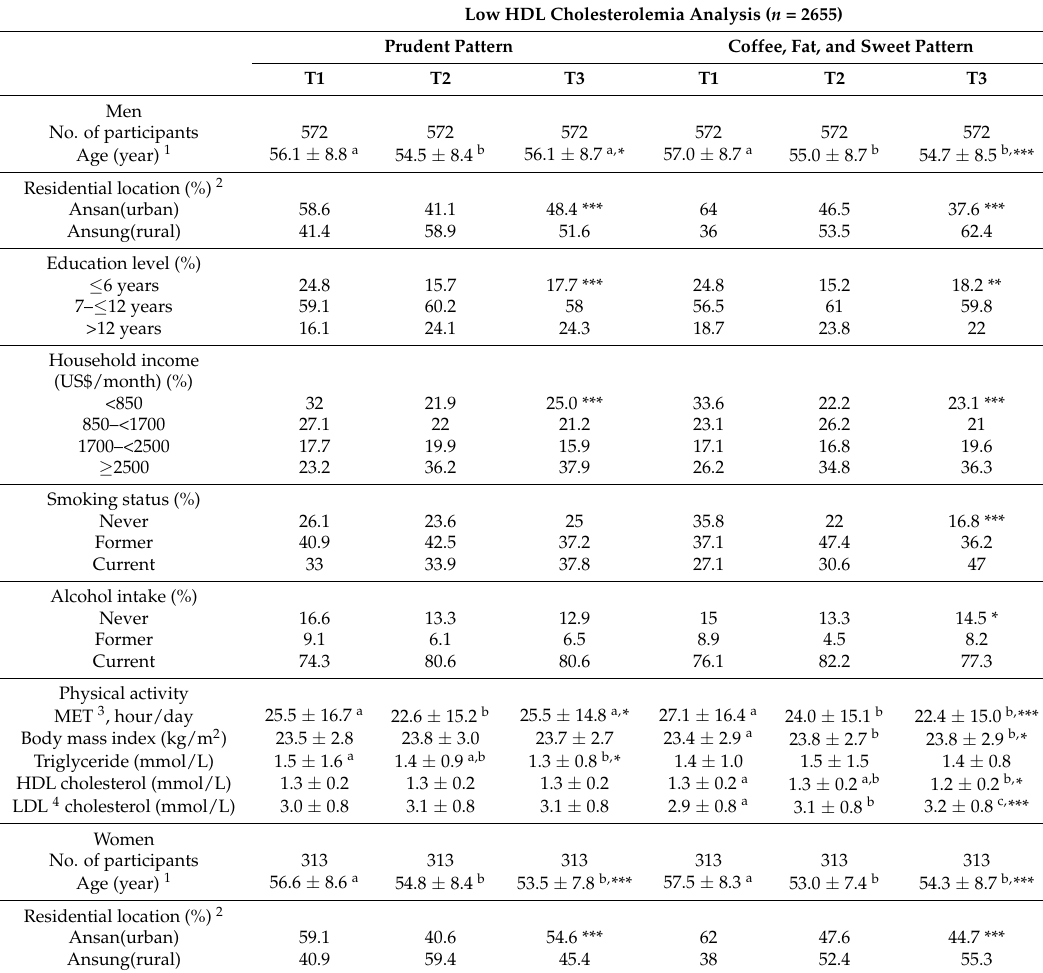
Table 2. Characteristics of Korean adults in low high-density lipoprotein (HDL) cholesterolemia analysis according to the tertile (T) categories of dietary pattern